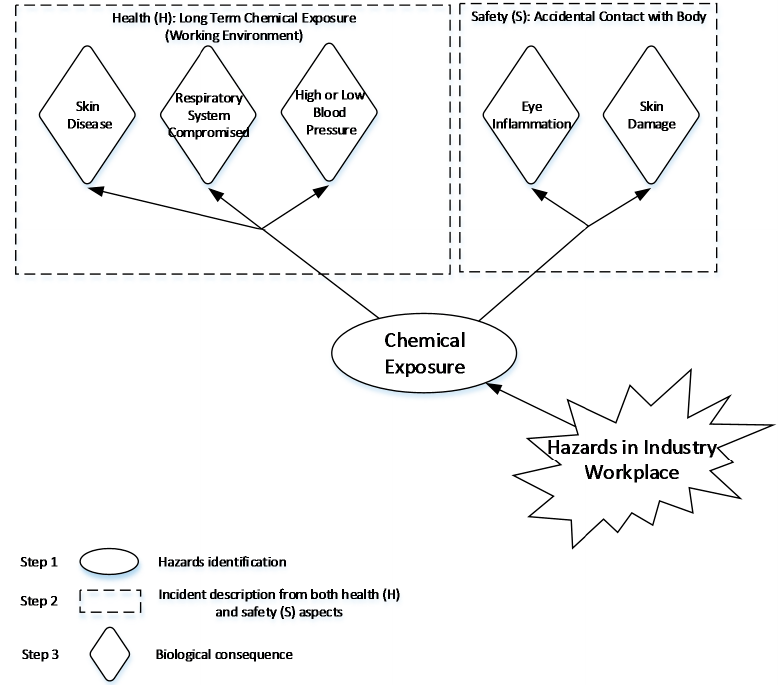
Figure 1. The three steps in designing the conceptualization